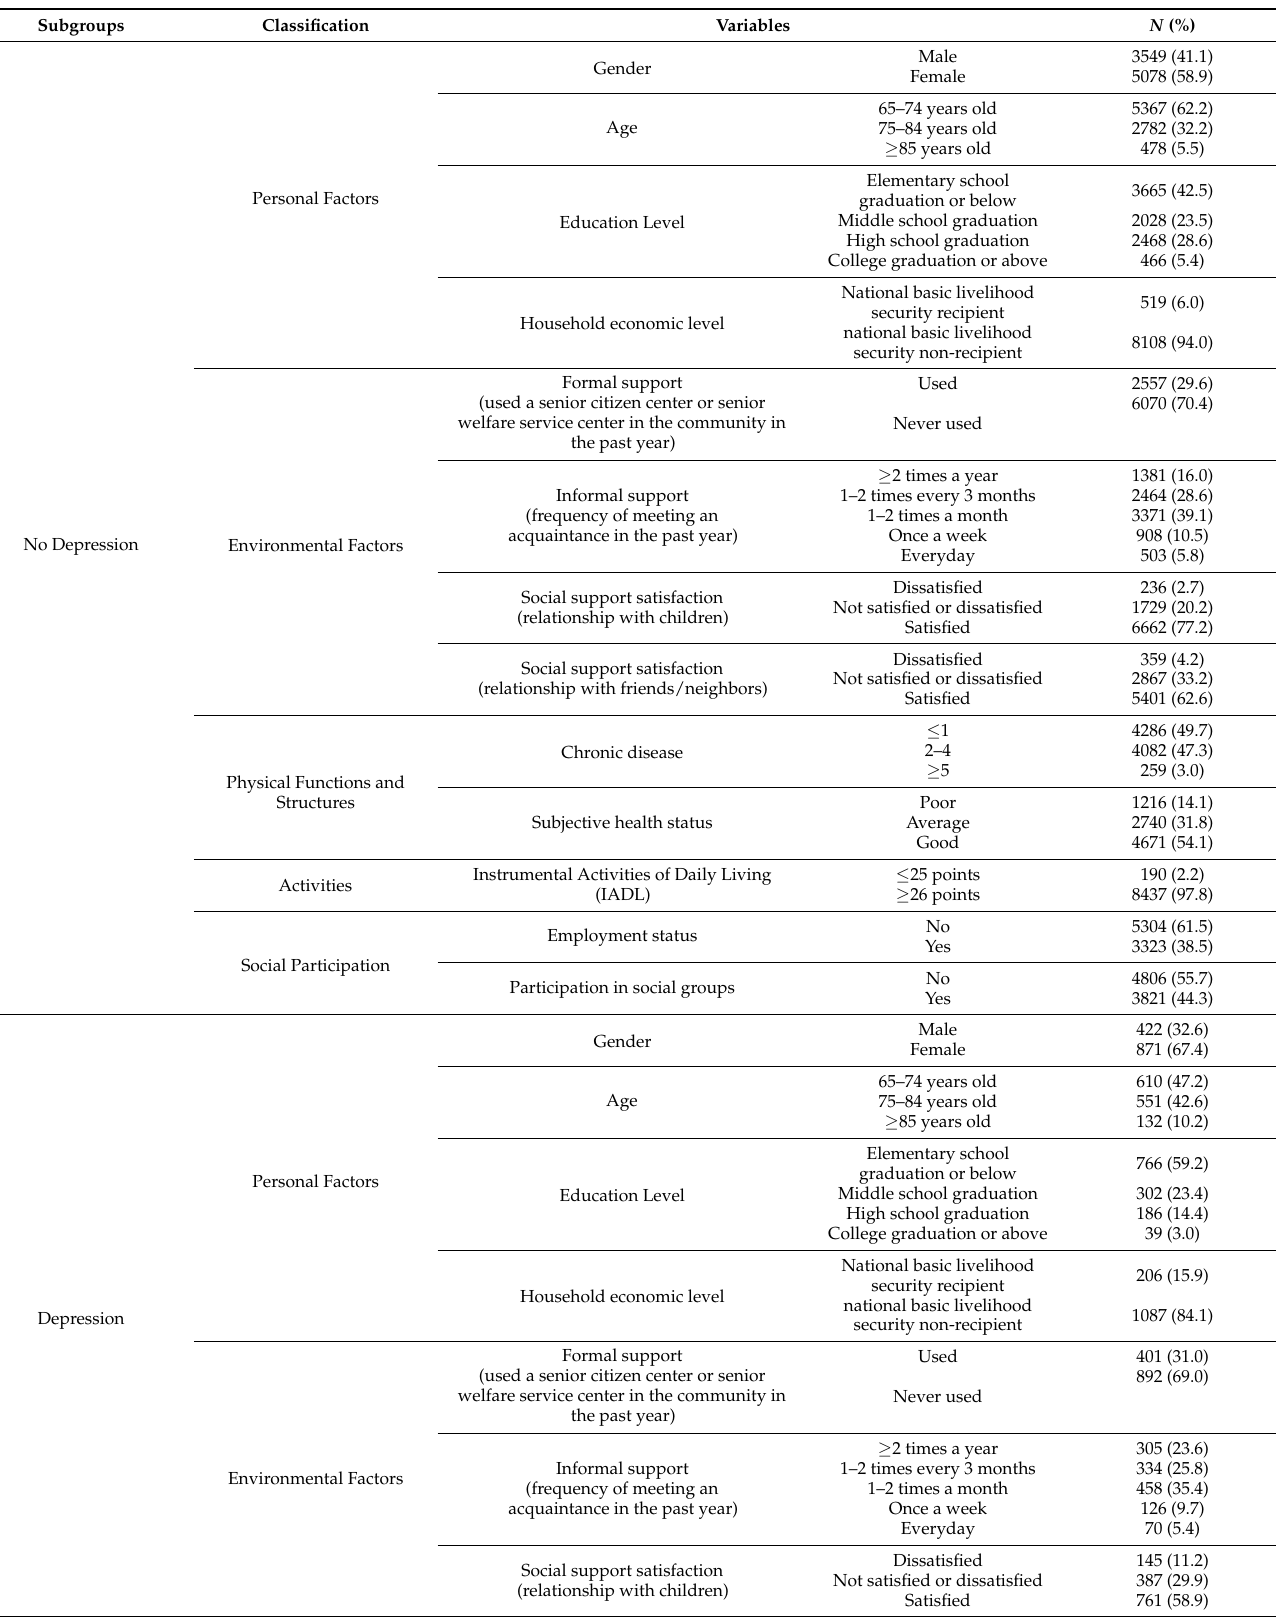
Table 1. General characteristics of study